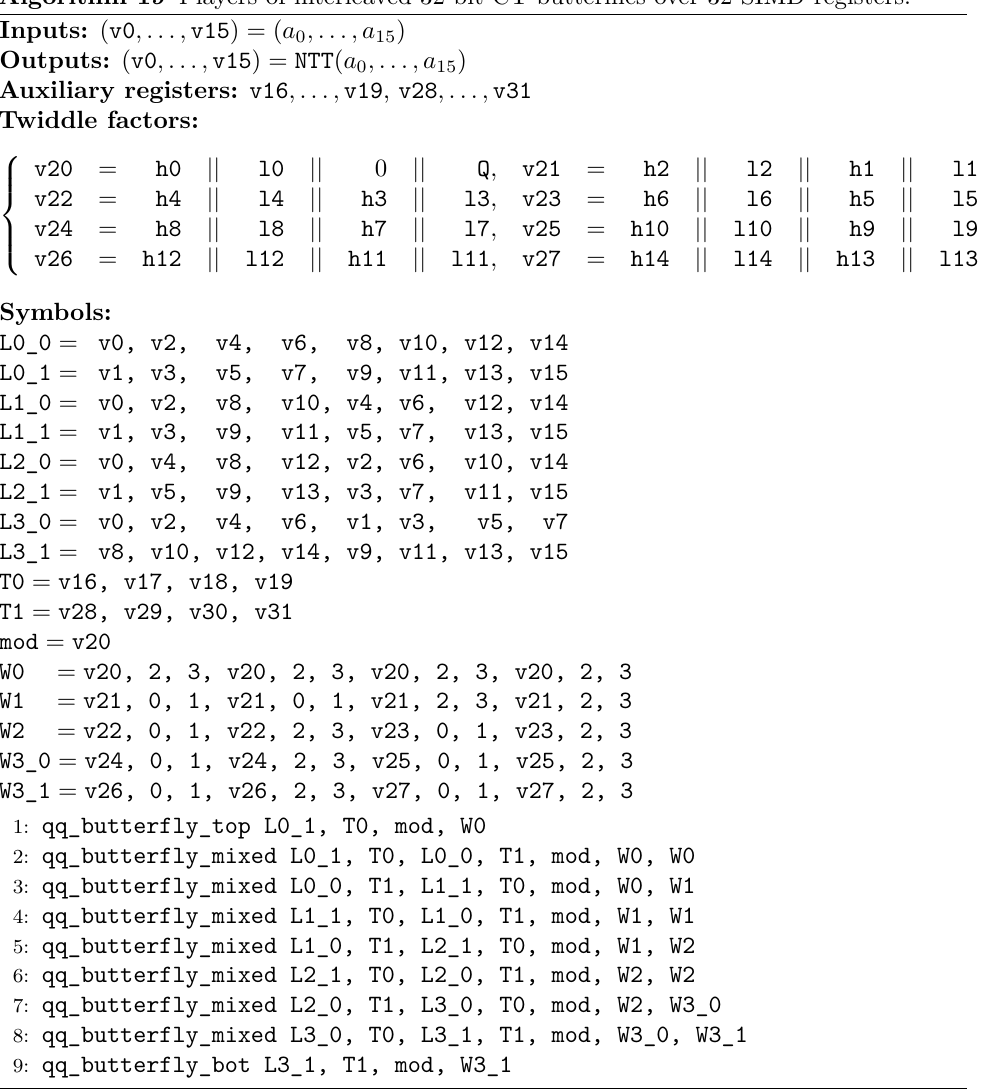
Algorithm 19 4 layers of interleaved 32-bit CT butterflies over 32 SIMD